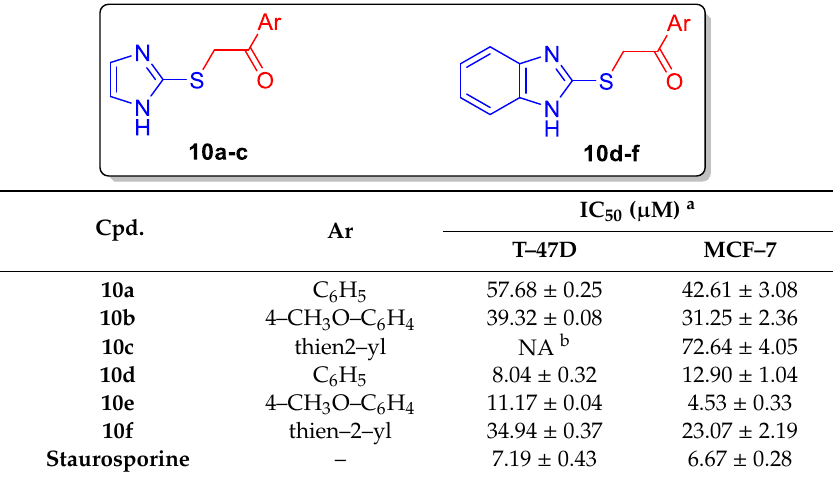
Table 3. In vitro anticancer activity of imidazole derivatives ( 10a–c ) and benzimidazole derivatives ( 10d–f ) against breast cancer T4–7D and MCF–7 cell lines.